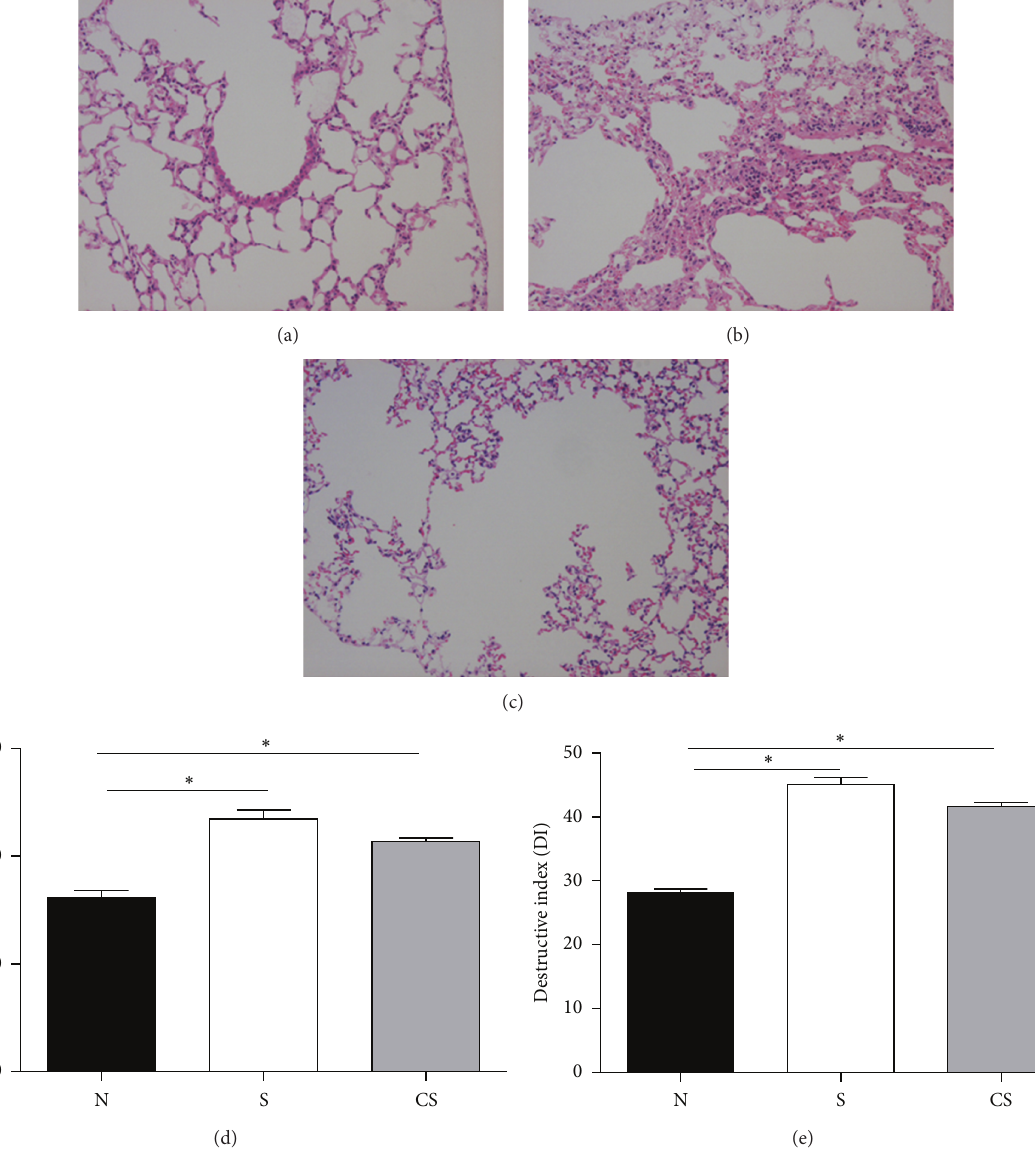
Figure 1: Cigarette smoke-induced alveolar enlargement is irreversible. Representative photomicrographs of hematoxylin and eosin stained lung tissue of nonsmoke mice (a), smoke-exposed mice (b), and smoking cessation mice (c). Magnification × 100. Morphometry of the lungs in mice exposed to air, mice exposed to cigarette smoke for 24 weeks, and mice exposed to cigarette smoke for 24 weeks plus a smoking cessation period of 12 weeks: (d) Lm and (e) DI values of mice. Results are expressed as means ± SEM. 𝑛 = 10 animals/group; ∗ 𝑃 < 0.05